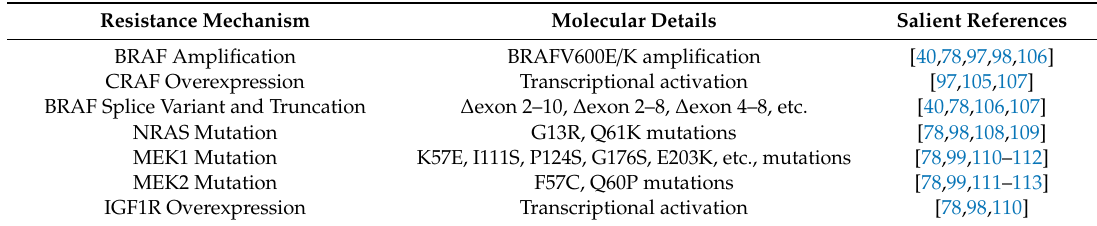
Table 2. List of MAPK reactivation-mediated resistance